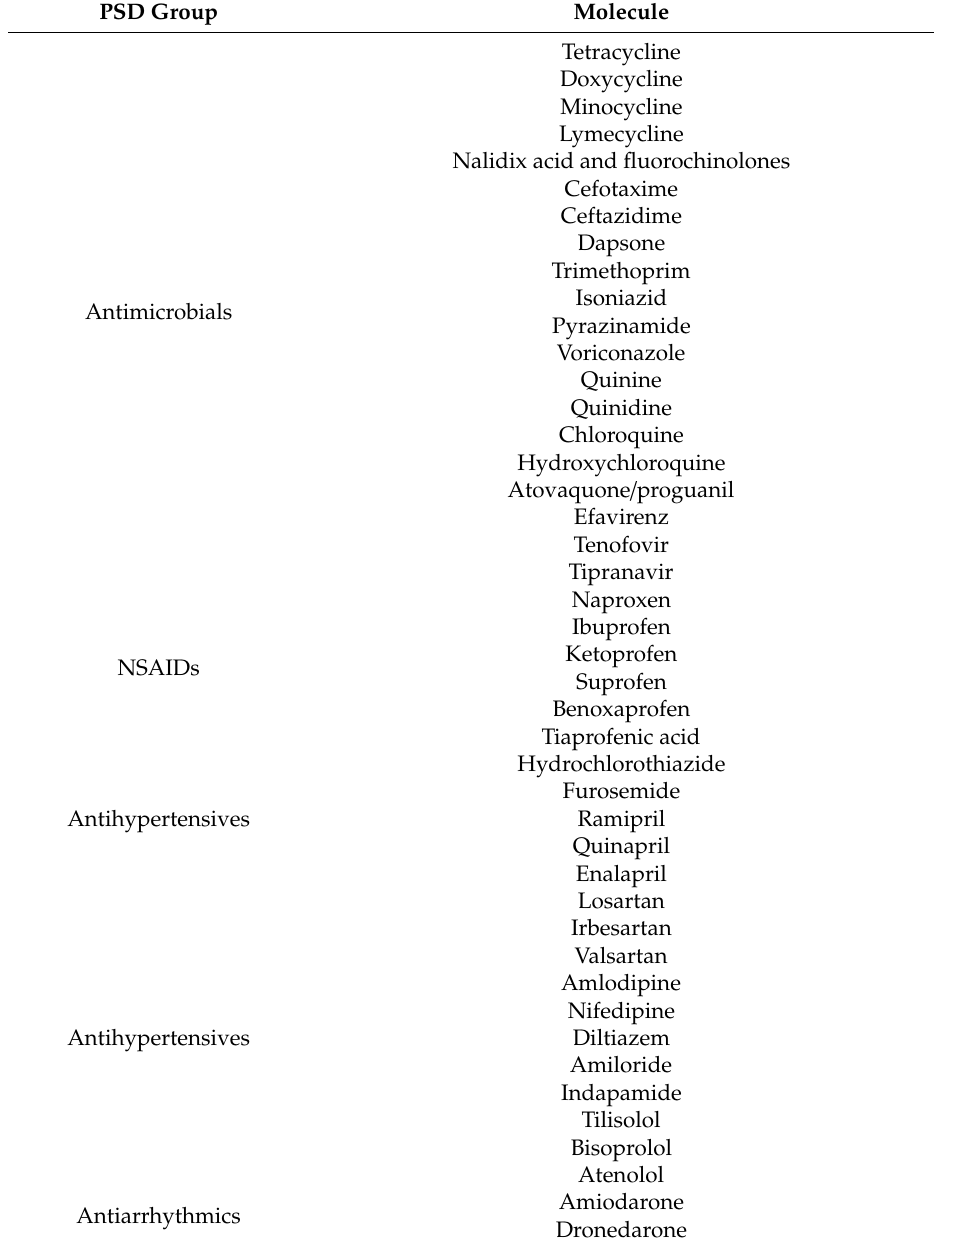
Table 2. Main groups and relatively molecules of photosensitive drugs discussed / cited in the